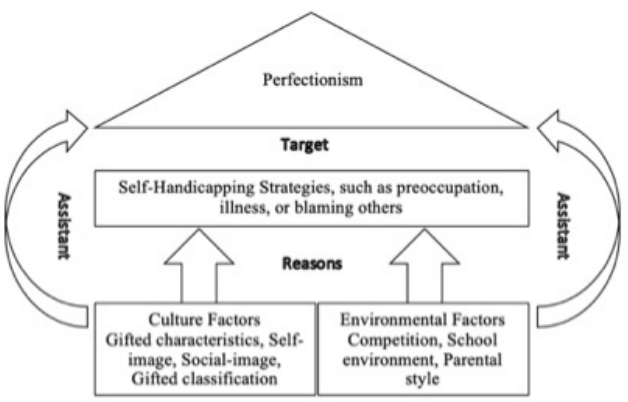
Figure 1 . An Explanatory Model of the Relationship between Perfectionism and Self-Handicapping among Gifted